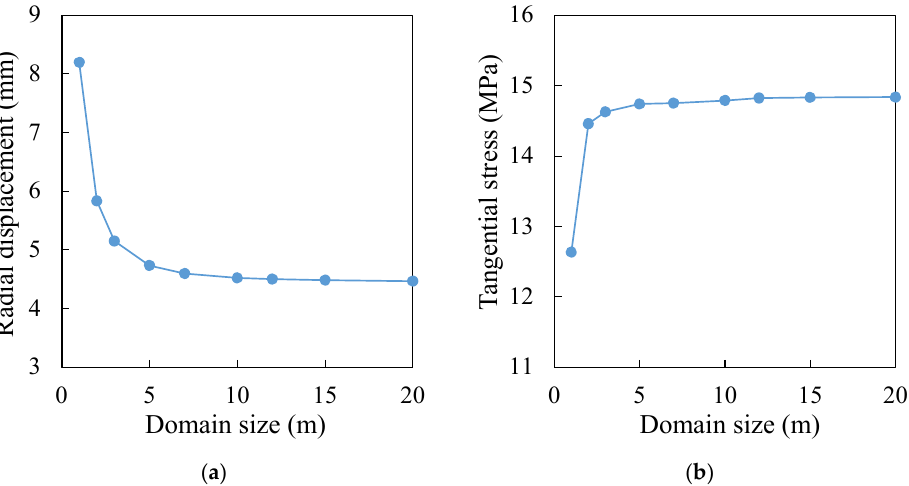
Figure A3. Variations of ( a ) radial displacement and ( b ) tangential stress at point M as functions of domain size.